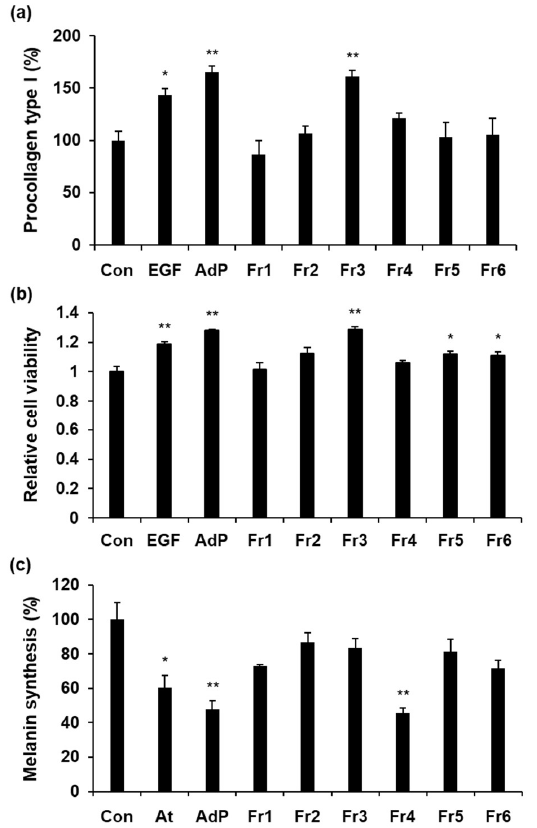
Figure 1. Fibroblast-activating (FA) and melanin-inhibiting (MI) domain mapping of AIMP1-derived peptide (AdP): ( a ) Foreskin fibroblasts were treated with EGF (1 μg/mL), AdP (0.1 μg/mL), and fragments of AdP (Fr1–Fr6; 0.1 μg/mL). After 24 h incubation, procollagen type I was determined in cultured media by ELISA; ( b ) after 48 h incubation, CCK8-assay was performed to monitor the proliferation of foreskin fibroblasts; ( c ) melanocytes, pre-treated with α-MSH (0.5 μM), were treated with albutin (At, 10 μM), AdP (1 μg/mL) and fragments of AdP (Fr1–Fr6, 1 μg/mL). After 48 h incubation, intracellular melanin was measured. Data are presented as the mean ± standard deviation (SD) ( n = 3). * p < 0.05 and ** p < 0.01, significantly different from the control.